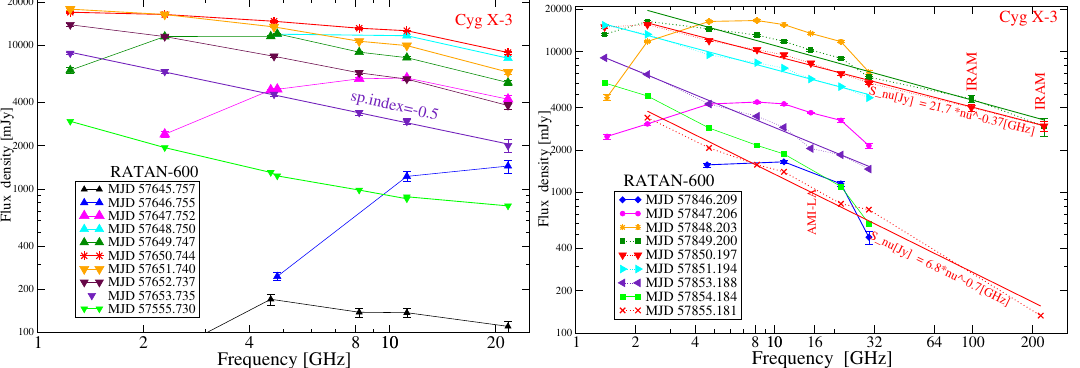
Figure 2. The radio spectra of the first flare ( left ) in September 2016 and the second one in April 2017 ( right ). There are clear transitions from the optically-thick mode to the optically-thin one in both